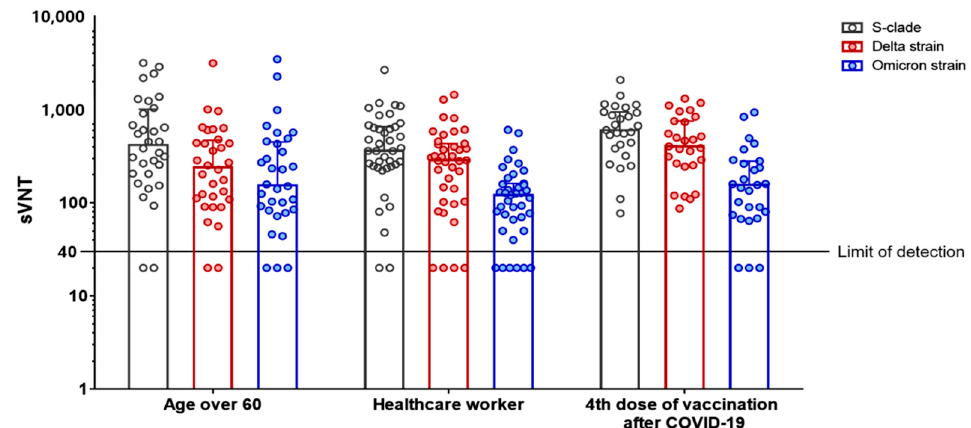
Figure 3. sVNT results after a second booster (fourth dose) vaccination after Omicron variant infection. Black, red, and blue dots indicate the sVNT titer against the S clade, Delta variant, and Omicron variant, respectively. Bars indicate the medians, and error bars indicate the interquartile ranges in each group. Asterisks indicate p < 0.05. Table 3. Comparison of serologic results in each cohort that did or did not receive subsequent 4 th vaccination and with history of 3 rd vaccination before SARS-CoV-2 infection.